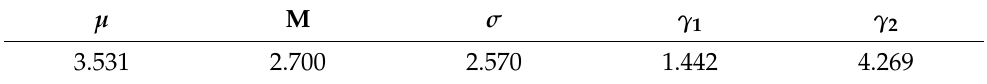
Figure 6. Box plot and TTT plot of the tumor size of the lung cancer patients. Table 6. Descriptive statistics of the tumor size of the lung cancer patients.